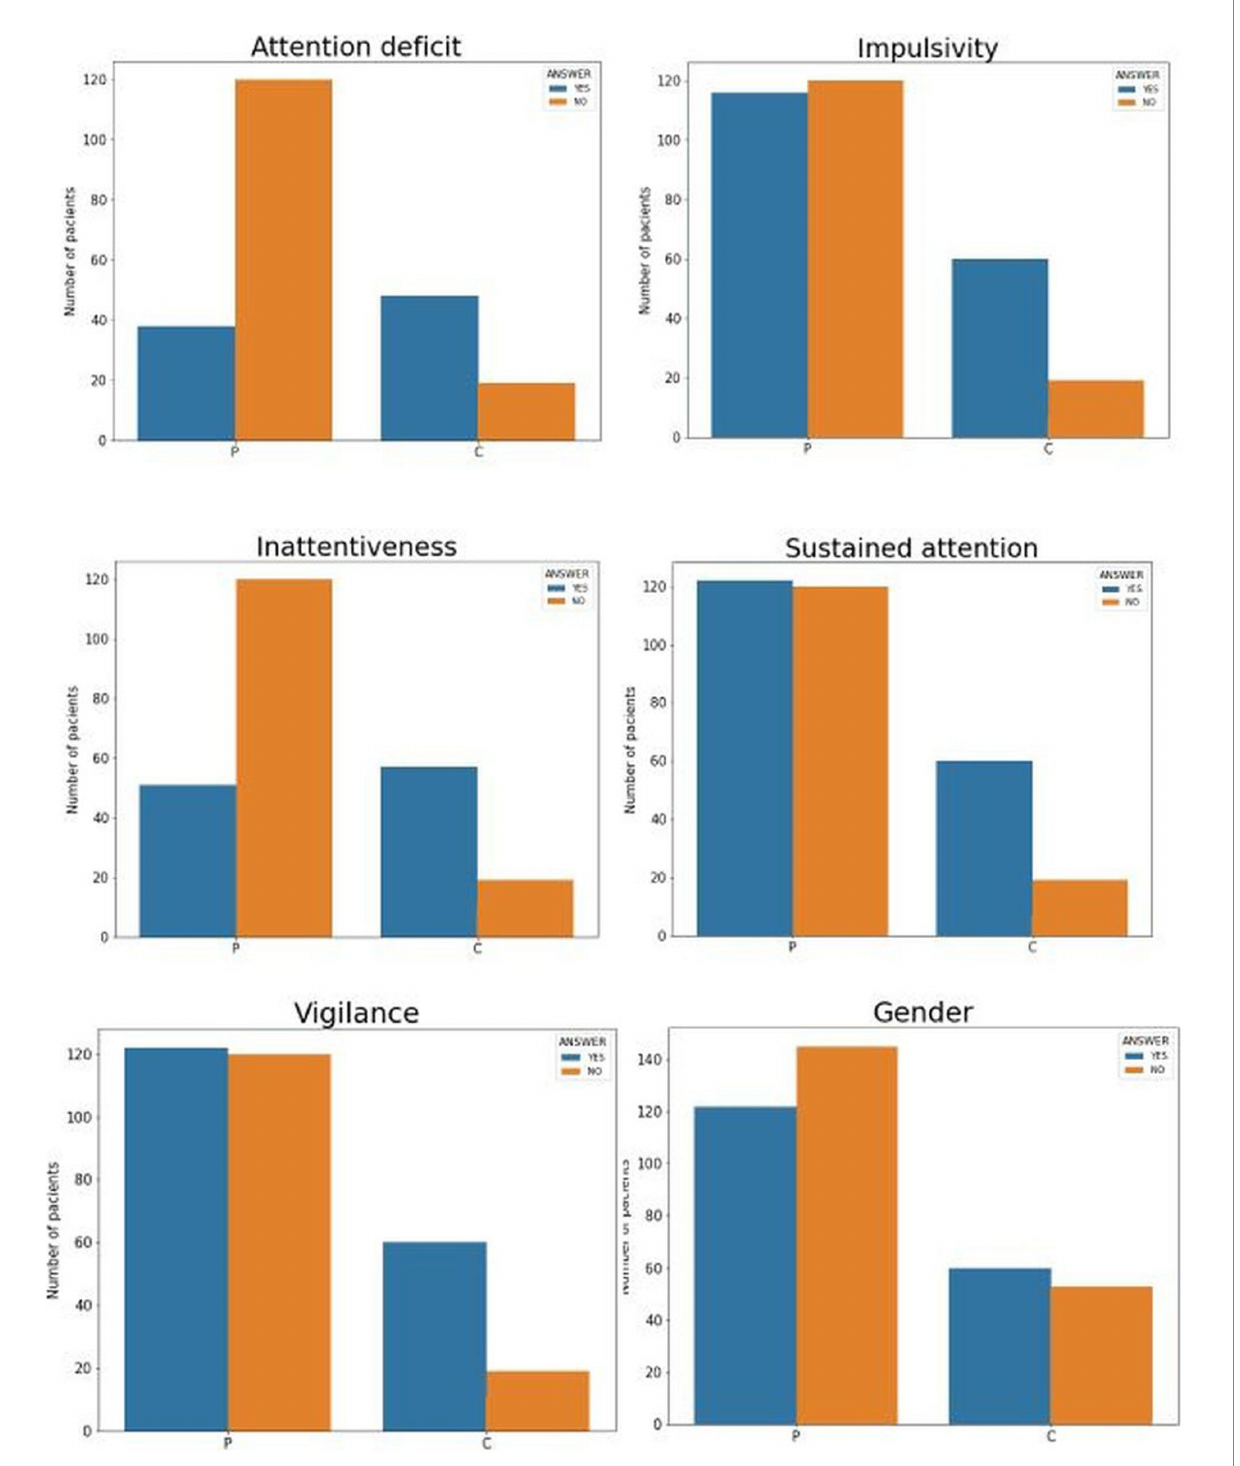
FIGURE 1 Graph of the contingency tables by groups and normalized, where each bar corresponds to the percentage of each value by groups. Each drawing represents for each dichotomous variable the group differences, with C being the control group and P the diagnosed group. The following acronyms mean the six dichotomous variables: DAT, attention deficit; INAT, inattentiveness; IMPUL, impulsivity; AT.SOST, sustained attention; VIGIL, vigilance; and finally, Gender.